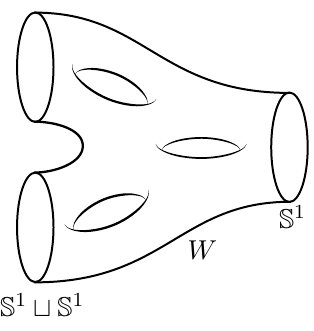
Figure 1 . Simple example of an unoriented cobordism relation between two copies of the circle ( S 1 t S 1 ) and a single S 1 by a surface of genus 3 with